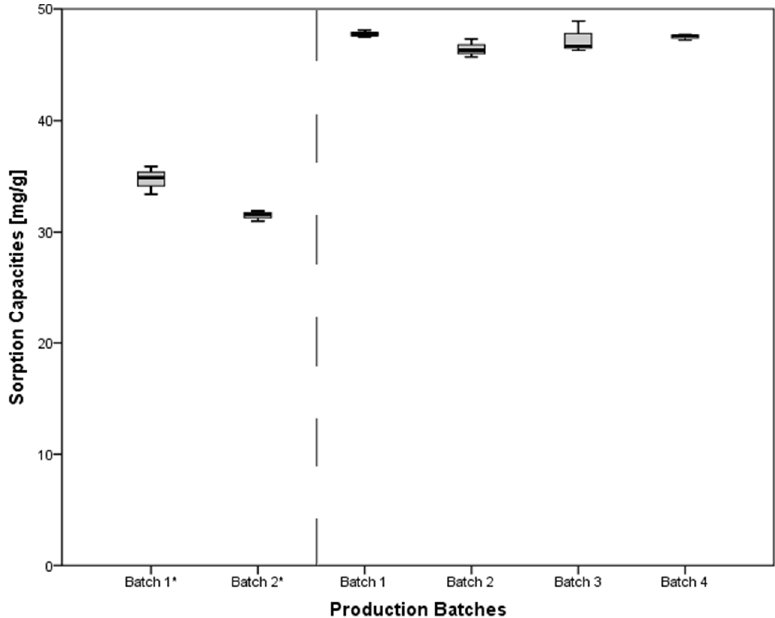
Figure 6. Evaluation of different production batches of GFH by sorption capacities for Cu: batch experiments marked with * contained 0.4 ± 0.05 g sorbent instead of 0.3 ± 0.05 g sorbent in 250 mL solution.